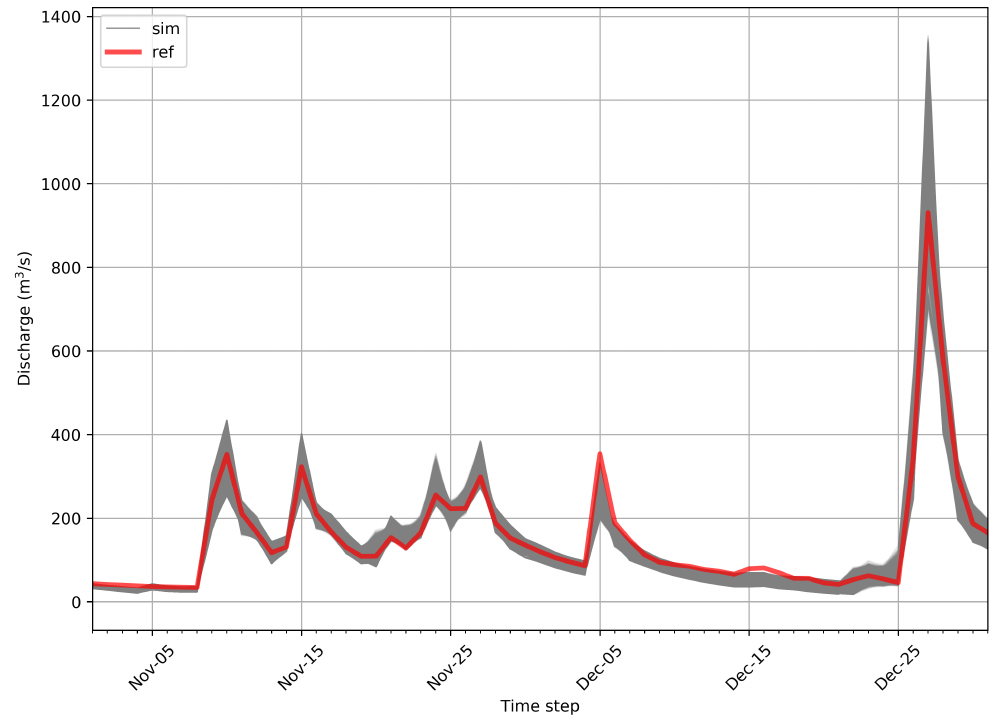
Figure 12. Observed (red) and calculated (gray) discharges for the November and December 1882 using the 100 simulated realizations.